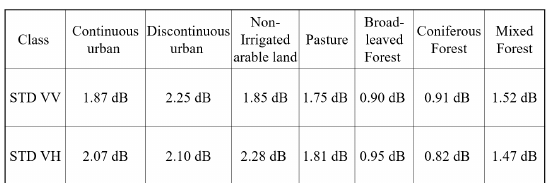
Table 2: Standard deviation of the backscatter values within each class, averaged for all acquisition